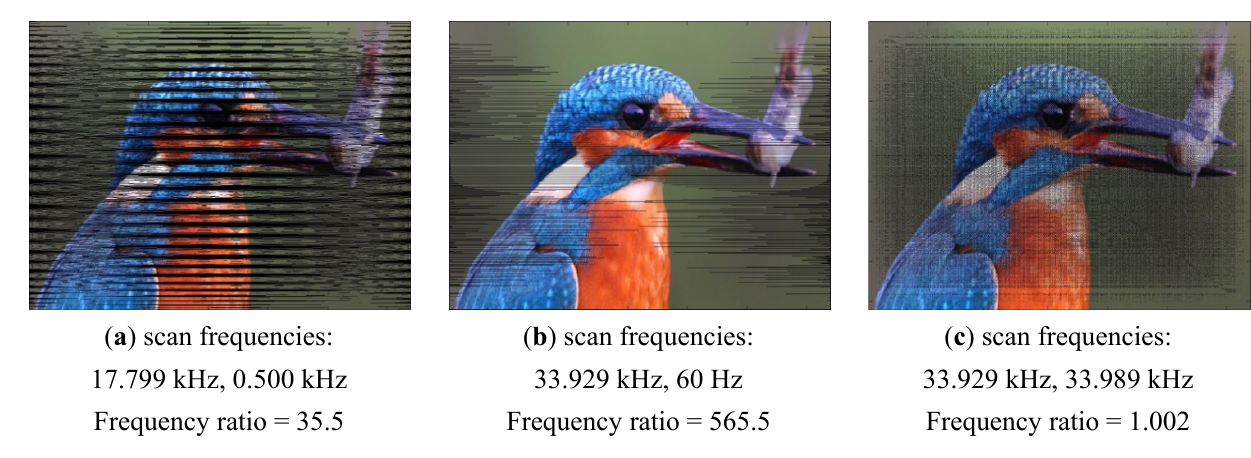
Figure 22. Simulation of Lissajous laser projected images based on three different scanning mirrors. The integration time is 1/60 s and the source image has a resolution of